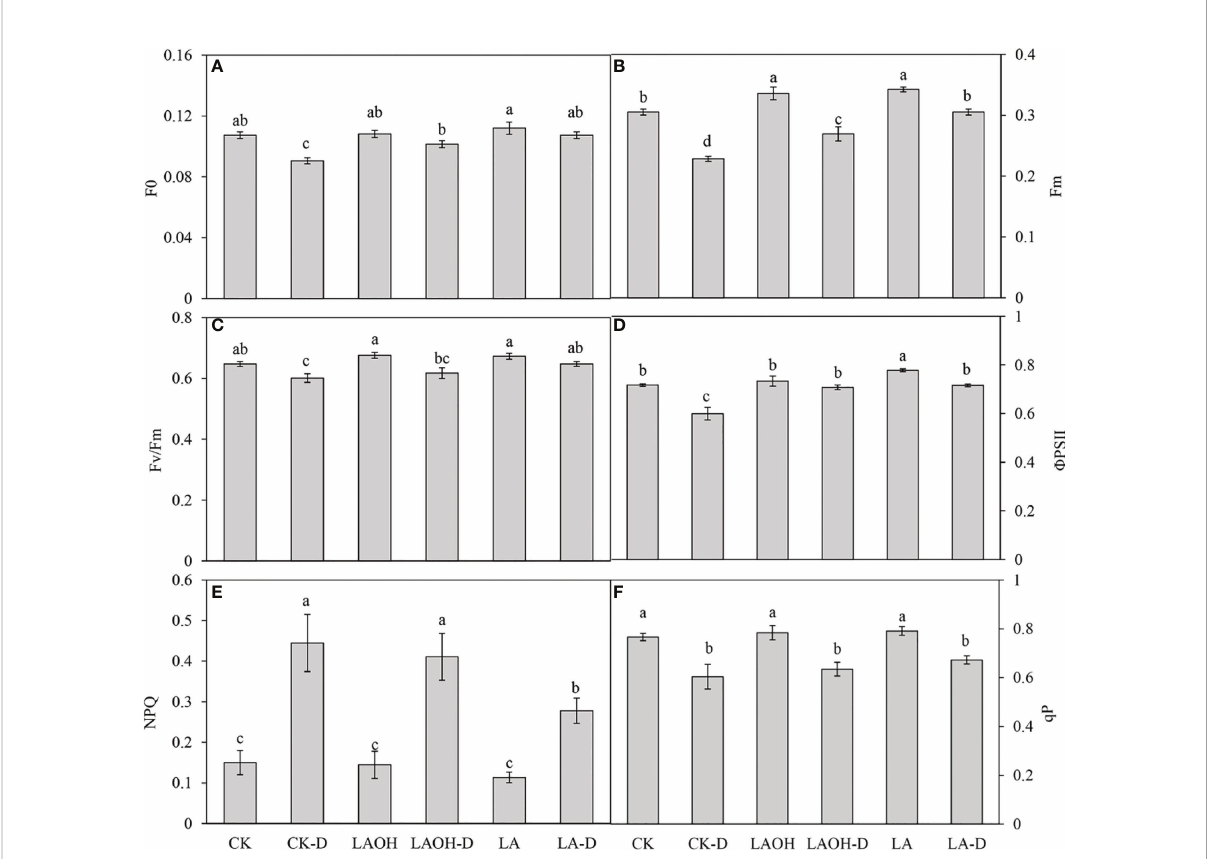
FIGURE 7 Changes in chlorophyll fl uorescence parameters of peach seedings under drought conditions. (A) F0; (B) Fm; (C) Fv/Fm; (D) F PSII; (E) NPQ; (F) qP. Duncan ’ s test and ANOVA were used. Signi fi cant differences (P < 0.05) are indicated by different letters.